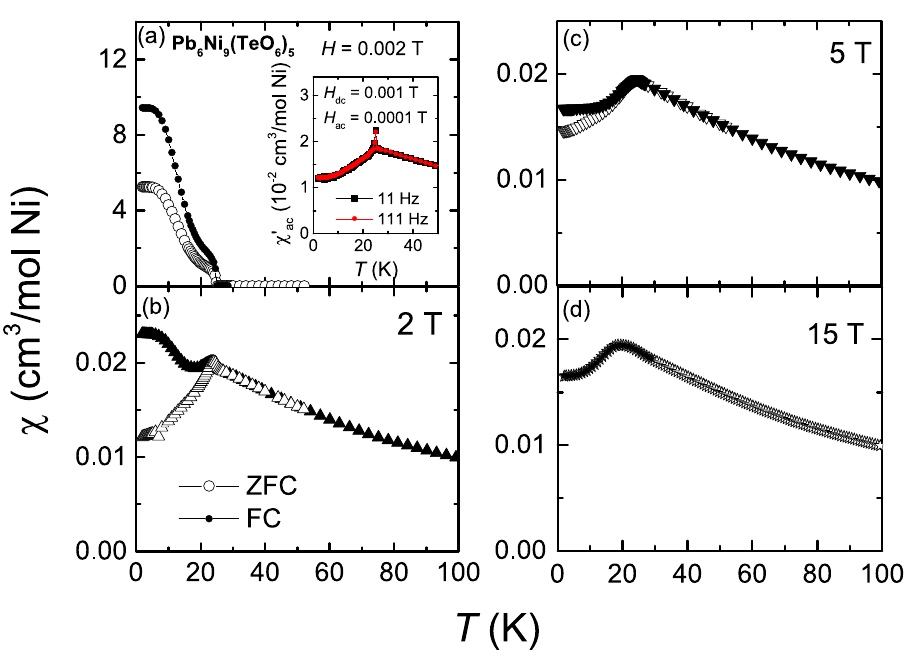
Figure 3. ZFC and FC χ ( T ) at different fields. Open symbols indicate the ZFC data, while the filled circles indicate field cooled (FC) data. The inset of ( a ) shows the plot of χ′ ac ( T ) at the frequencies of 11 Hz and 111